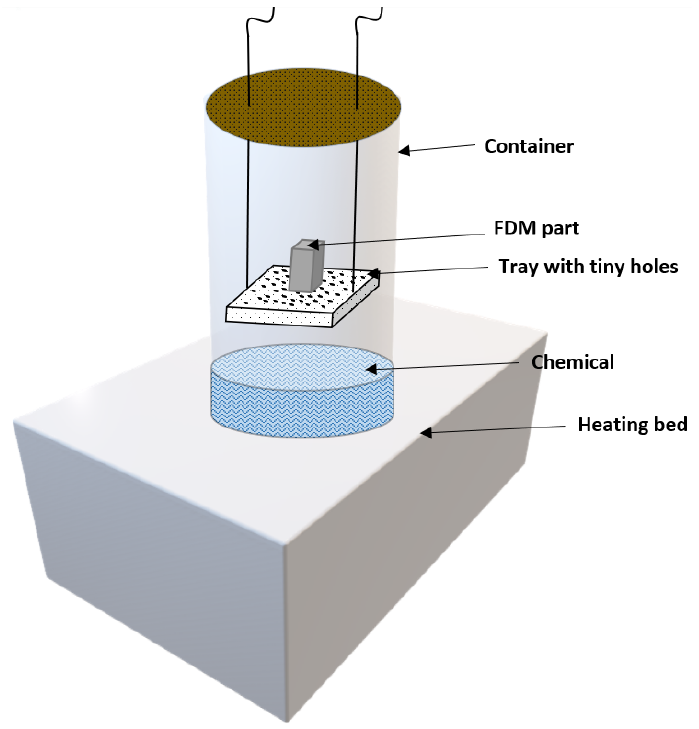
Figure 11. Vapor smoothening.